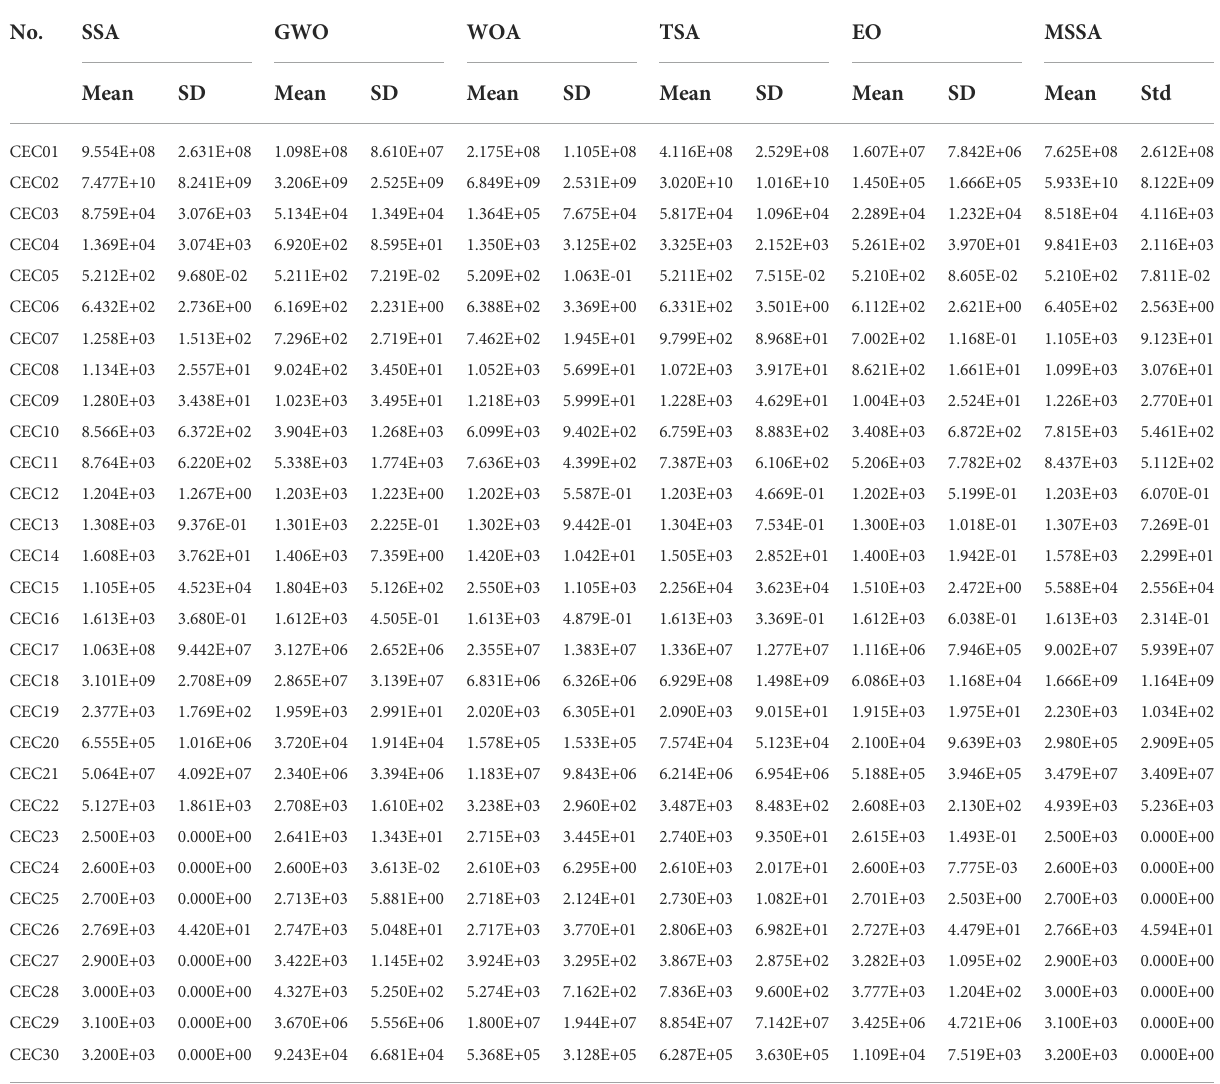
TABLE 6 CEC2014 function optimization